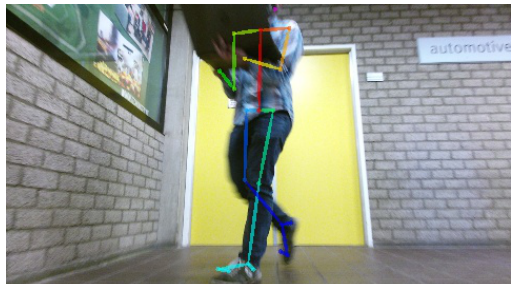
( a ) Visualization of the routing options considered in the